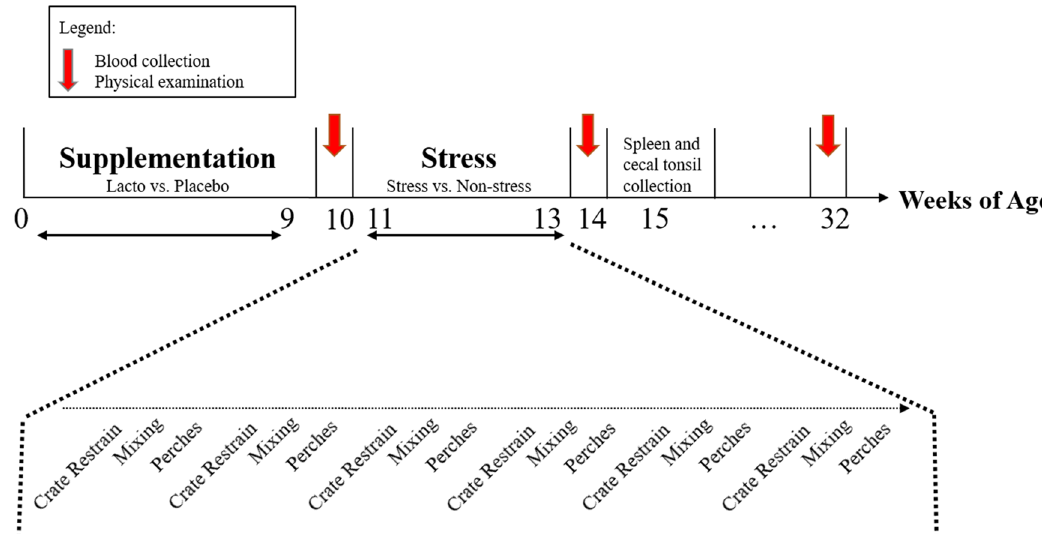
Figure 2. Schematic diagram of the experimental timeline. The Lacto or Placebo supplementation started when birds were 1 day old and lasted 9 weeks. The stress treatment spanned weeks 11–13. Physical examinations and measurements of behaviour, blood samples, and cecal droppings samples were conducted at 10, 14, and 32 weeks of age. Spleen and cecal tonsil samplings were performed at 15 woa from 36